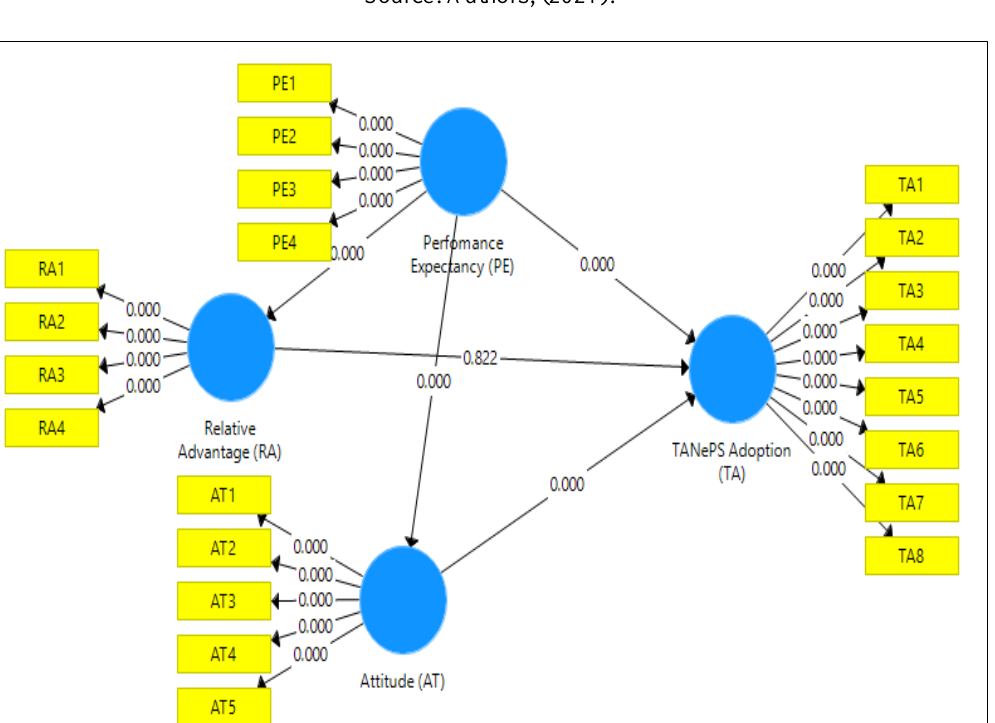
Figure 9: Statistical Significance of the Hypotheses. Source: Authors,